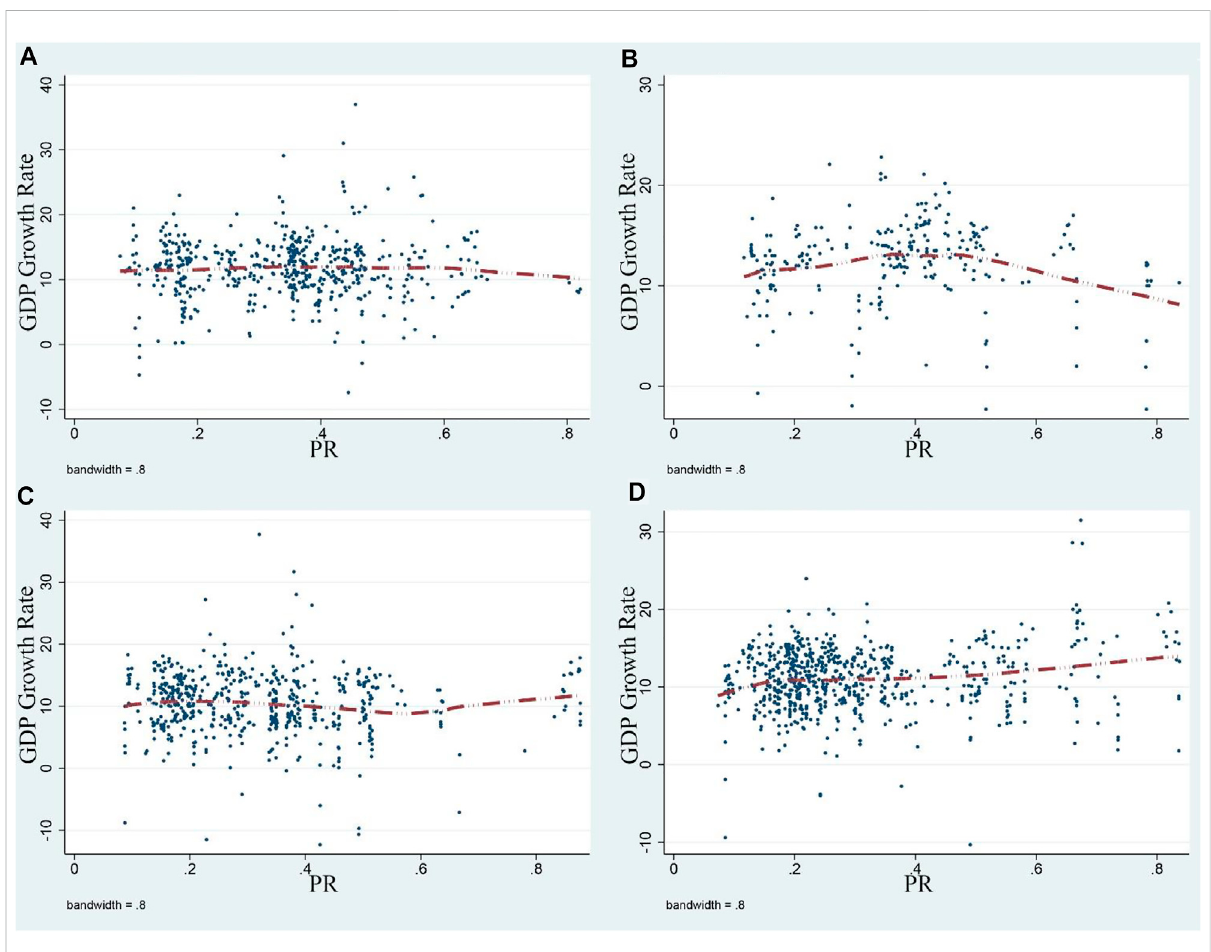
FIGURE 10 Correlation analysisbetween thespatial concentrationandeconomicgrowth ofregional centralcities at (A) growth period, (B) maturityperiod, (C) recession period, (D) regenerative